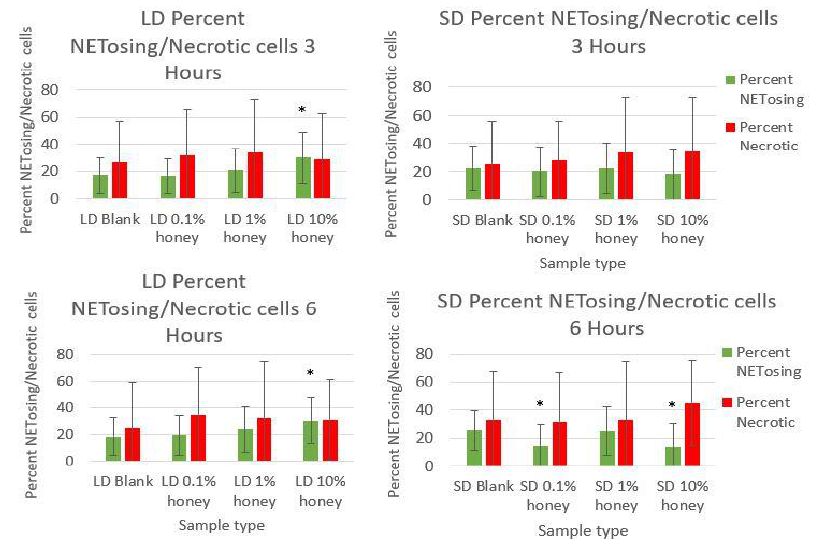
Figure 6. The reduction in NETosis is not caused by honey-driven necrosis. The percentage of cell nuclei identified as NETosing or necrotic are shown for LD and SD templates at 3 and 6 h. * indicates a significant di ff erence from the respective LD or SD blank. Sample size of 3 images per replicate, 4 replicates per timepoint per experiment, with 3 unique donor experiments. Raw data is available in Supplementary Spreadsheet 4.